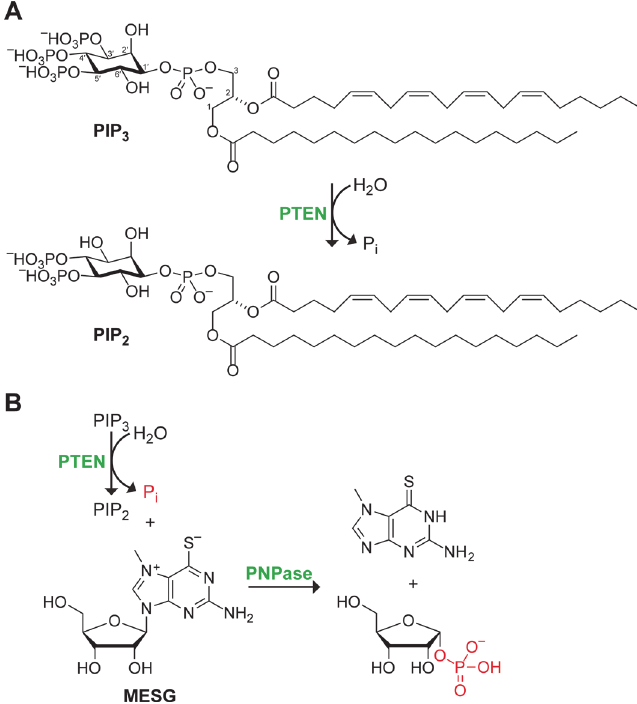
Figure 1. Scheme of assay for catalysis by PTEN. (A) PTEN catalyzes the hydrolysis of phosphatidylinositol-3,4,5-trisphosphate (PIP 3 ) to form inorganic phosphate and phosphatidylinositol-4,5- bisphosphate (PIP 2 ). Canonically, the fatty acids are arachidonic acid (20:4) and stearic acid (18:0). (B) In the coupled enzyme assay, purine nucleoside phosphorylase (PNPase) catalyzes the reaction of the inorganic phosphate produced by PTEN with 7-methyl-6-thioguanosine (MESG). Upon release, 7-methyl-6- thioguanine undergoes tautomerization, leading to a marked increase in absorbance at 360